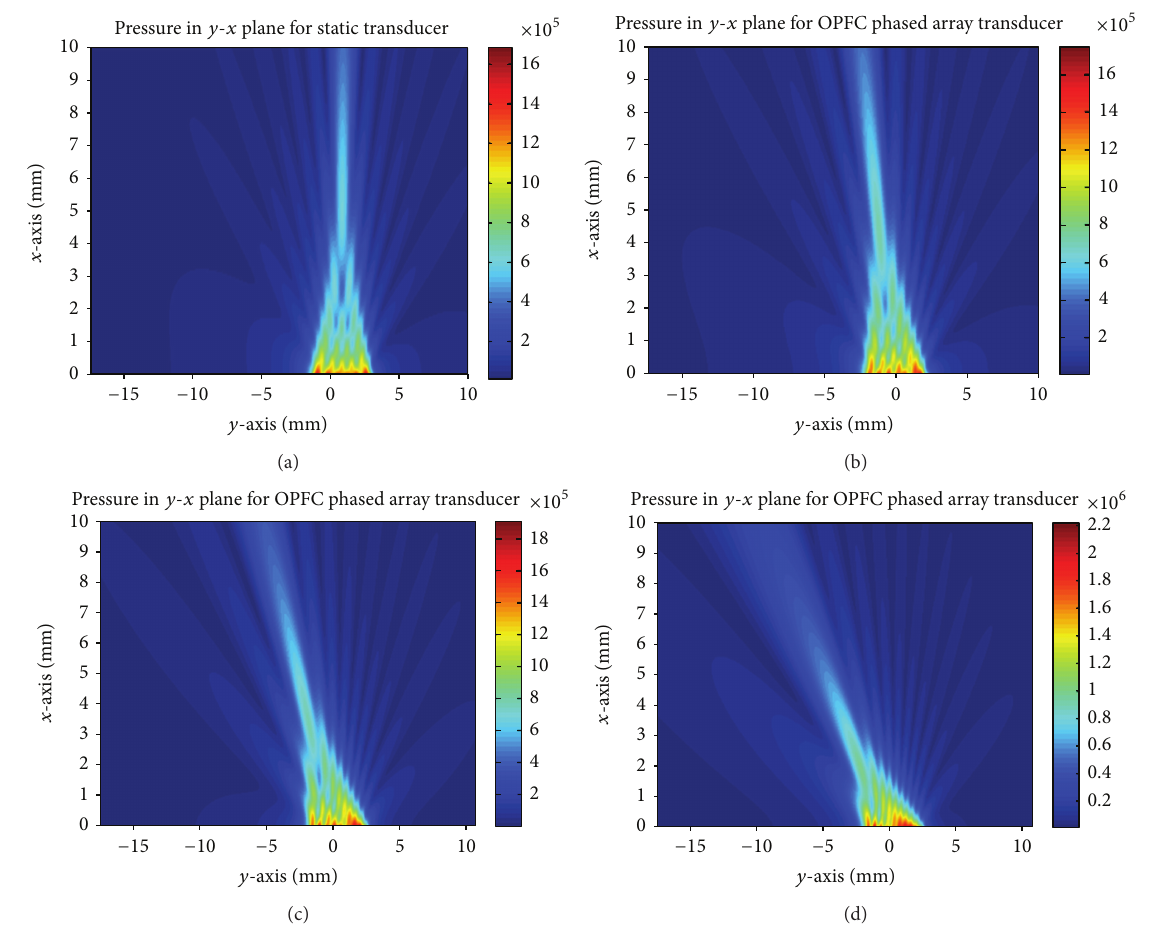
Figure 9: Acoustic pressure field generated by an OPFC phased array transducer for steering angles (a) 0 ∘ , (b) 15 ∘ , (c) 30 ∘ , and (d) 45 ∘